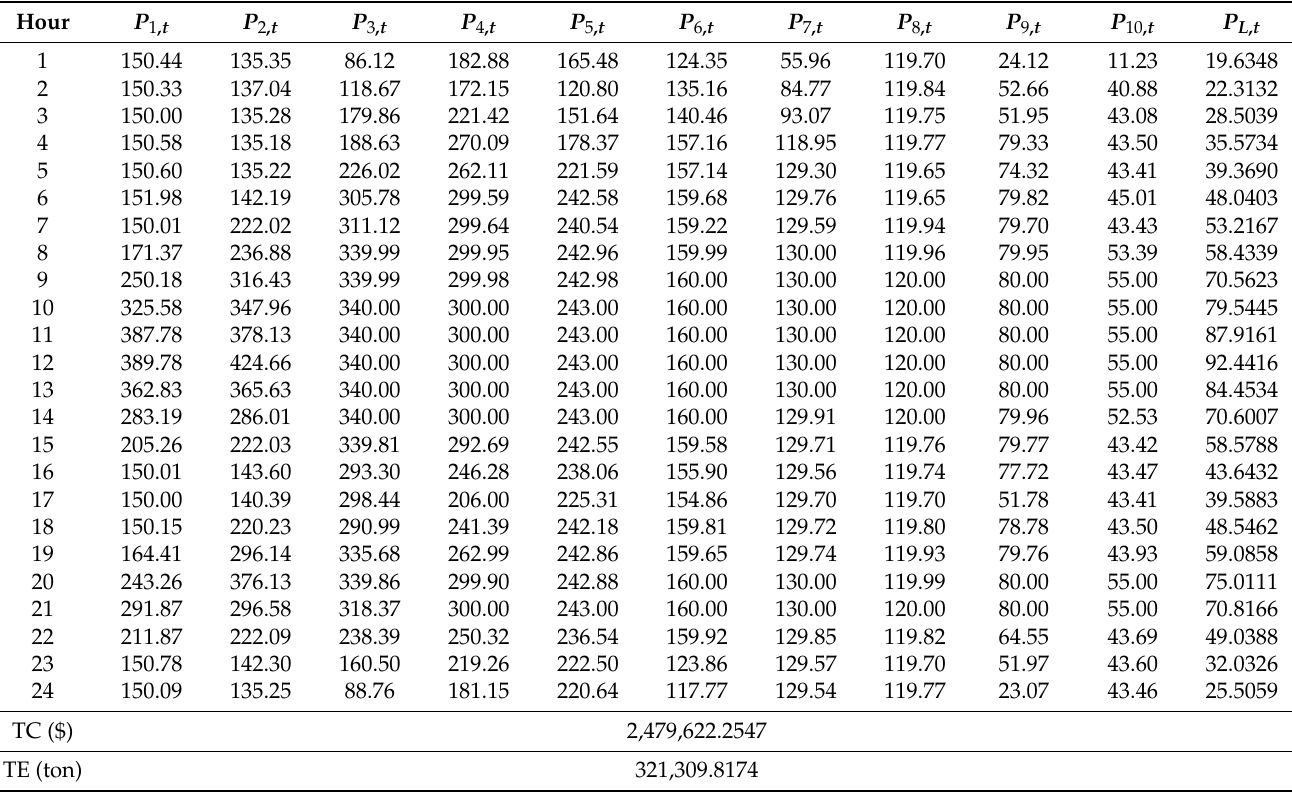
Table 6. Dynamic economic dispatch for case 3.